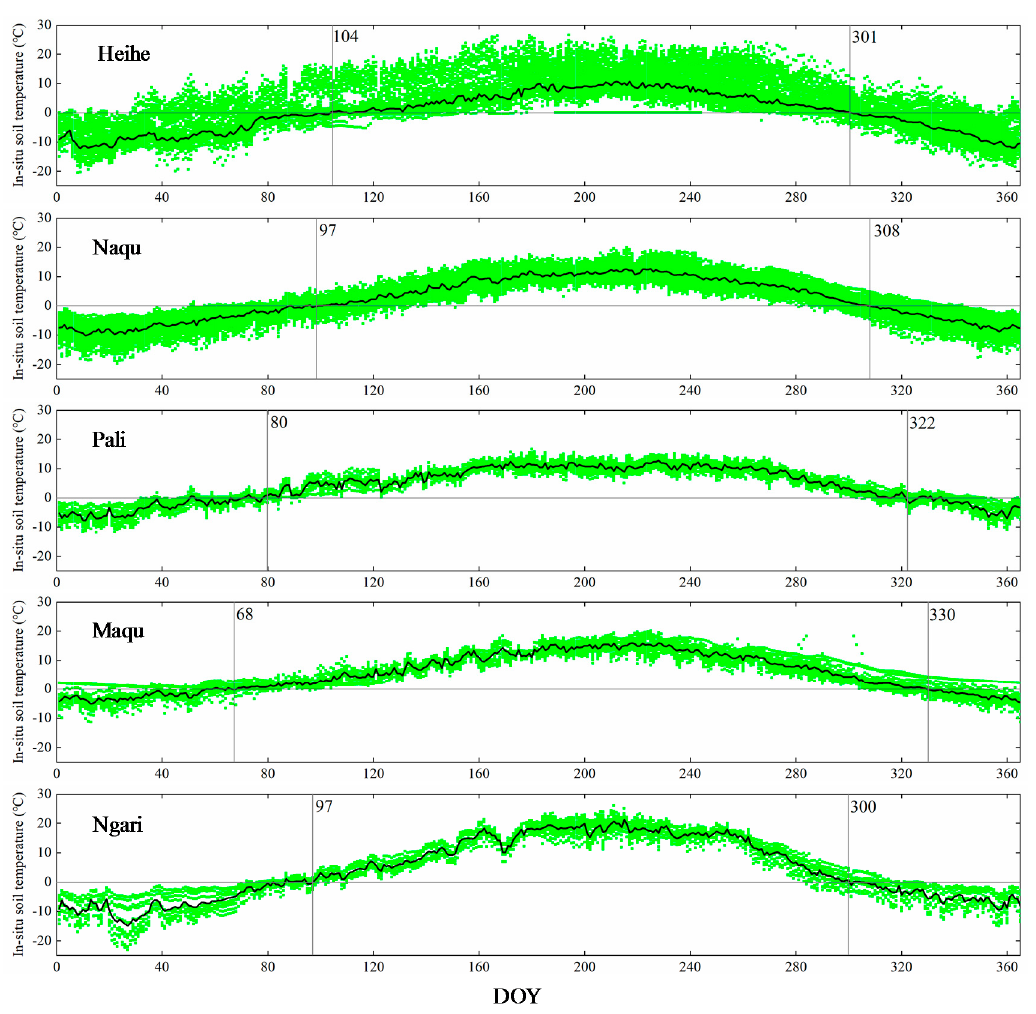
Figure 2. Annual mean in situ soil temperature (green points) and mean in situ soil temperature of the five in situ observation networks (bold black lines) .